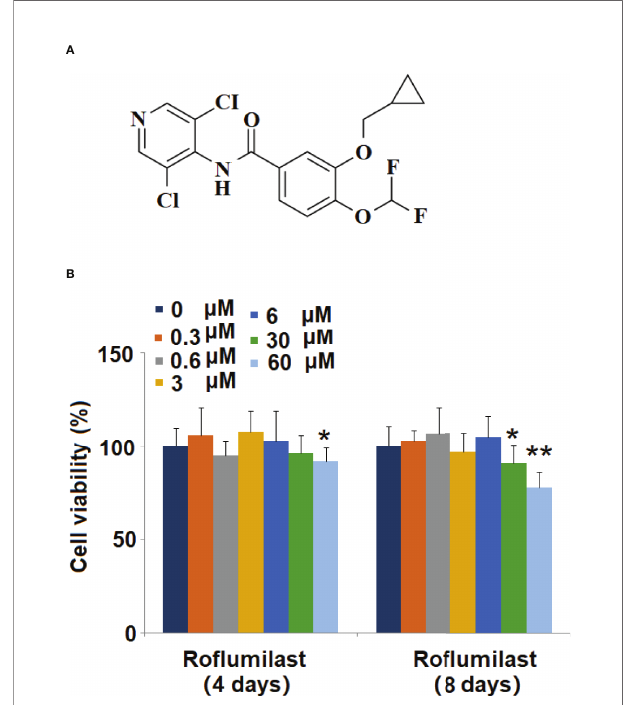
FIGURE 1 | Effects of Ro fl umilast on cell viability of 3T3-L1 cells. Cells were stimulated with 0.3, 0.6, 3, 6, 30, and 60 m M Ro fl umilast for 4 and 8 days. (A) Molecular structure of Ro fl umilast; (B) Cell viability was determined at day 4 and 8 (*, **, P < 0.05, 0.01 vs. vehicle control, n =